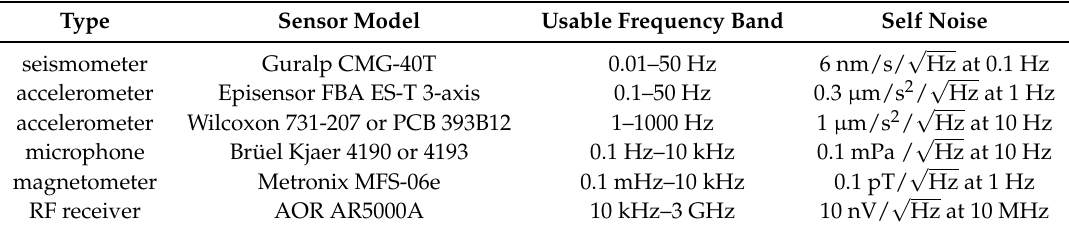
Table 1. Specifications for main environmental sensor types: the model, the frequency range in which they are used, and their typical